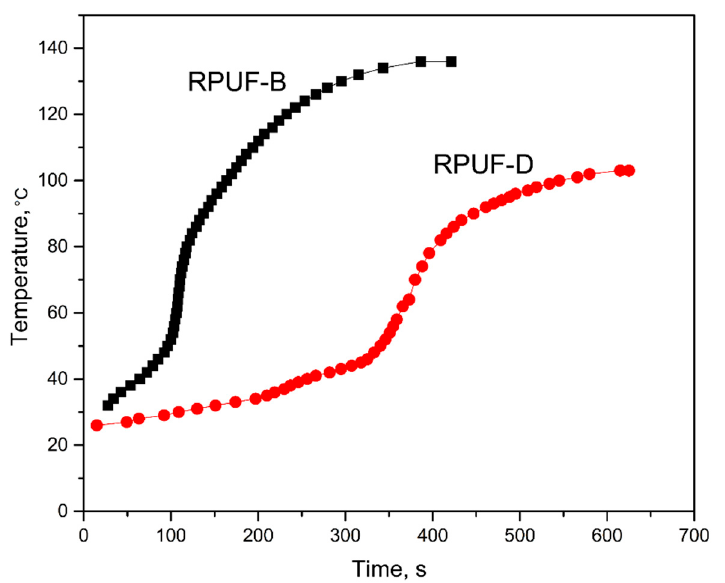
Figure 4. Inner temperature variation of foams prepared from unfiltered BBPs with (RPUF-B) and without (RPUF-D) neutralization by sodium hydroxide.